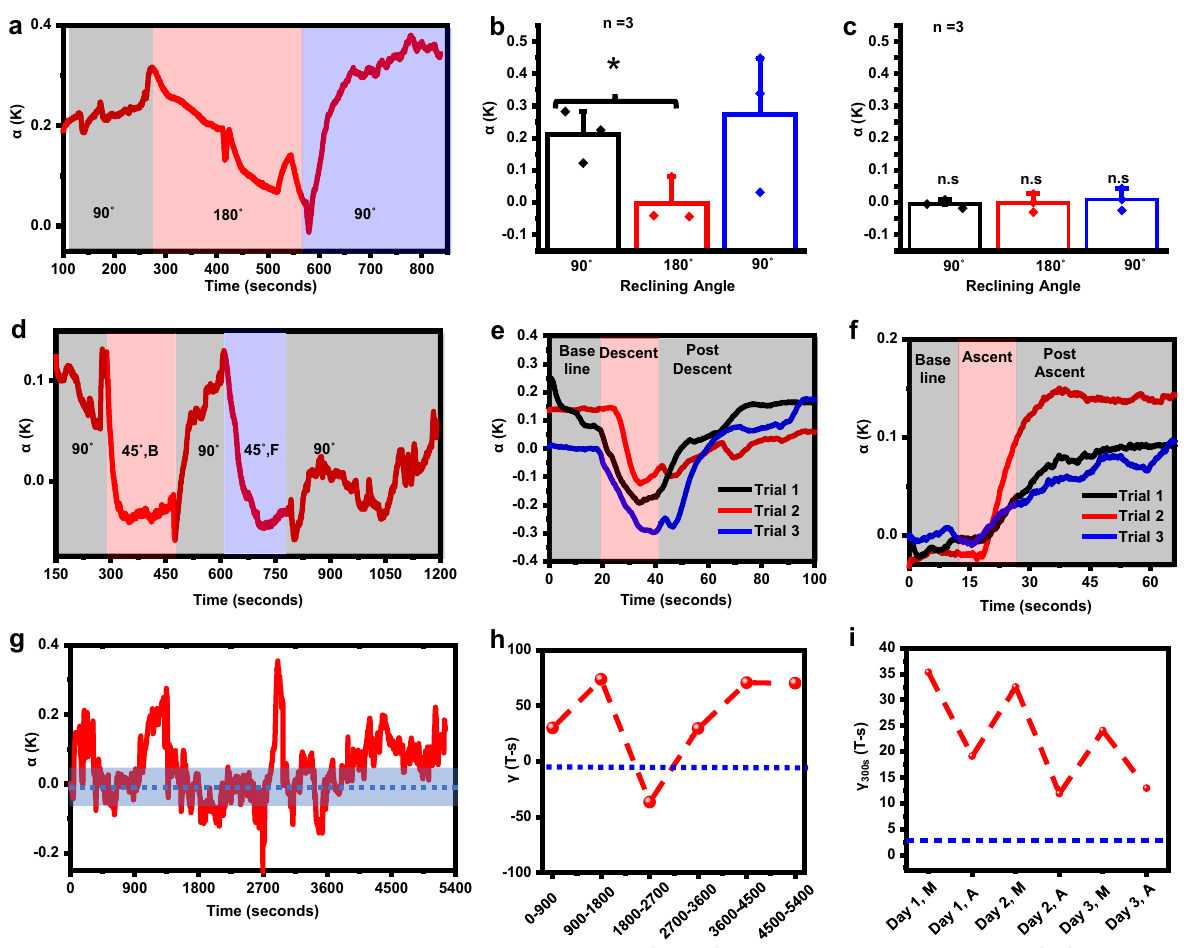
Fig. 5 Advanced measurements of continuous CSF hydrodynamics on healthy out-patients. a α computed for a healthy outpatient (Male, 21) at three positions, sitting up at 90°(grey shaded area), supine at 180°(red shaded area) and sitting up at 90° (blue shaded area). b α averaged over a 100 s window for the three positions, across n = 3 patients at on-shunt locations. c Same as b . but measured at off-shunt locations. d α for a volunteer (F,16) leaning forwards (F) and backwards (B) at 45°, and sitting up at 90°, respectively. e α computed for continuous measurement over on-shunt location as volunteer (Male, 21) outpatient descended on elevator moving at 1.5 m/s across an elevation of 17 m. f Same as e but measured while same volunteer ascended on elevator, with baseline adjusted to same starting value of α . g α computed for continuous 1.5-h measurement on volunteer (Male, 21) during normal activities, showing intermittent fl ow. h Area-under curve, γ , computed for α ( t ) over different sampling windows for data in g as a measure of total fl ow output during fi xed intervals. i γ computed over 5-min sampling window for same patient across three days, during morning (M) and afternoon (A) measurements showcasing variability in fl ow patterns across time of day. Error bars in b and c correspond to standard deviations across three consistent with corresponding changes in fl ow during the periods differences between measurements during an initial upright of acceleration, where descent reduces fl ow, to the level of back- fl ow period and a subsequent supine period as computed for a paired (Fig. 5d), and ascent enhances fl ow (Fig. 5f). t-test. Control measurements off-shunt show no thermal aniso- tropy, independent of body orientation, as expected (Fig. 5c). Patients can often identify instances of aberrant fl ow based on the onset of characteristic headaches. In one case, an otherwise healthy asymptomatic outpatient (F, 16) described changes in position from upright to leaning forward (45°) as a case for headaches, for example, during reading. Results from continuous monitoring on this patient (Fig. 5d) show that leaning both forward and backward (45°) leads to an instantaneous and signi fi cant reduction in fl ow that coincided with headaches. Reversal of fl ow, as indicated by a negative value of α , can also occur. In both cases, fl ow appears to recover to a positive, baseline value, though at different rates. In another instance, an otherwise healthy, outpatient (M, 21) complained of headaches during rapid inertial changes associated with riding on elevators in high-rise buildings. Measurements on this patient during three routine elevator ascents and descents reveal characteristics